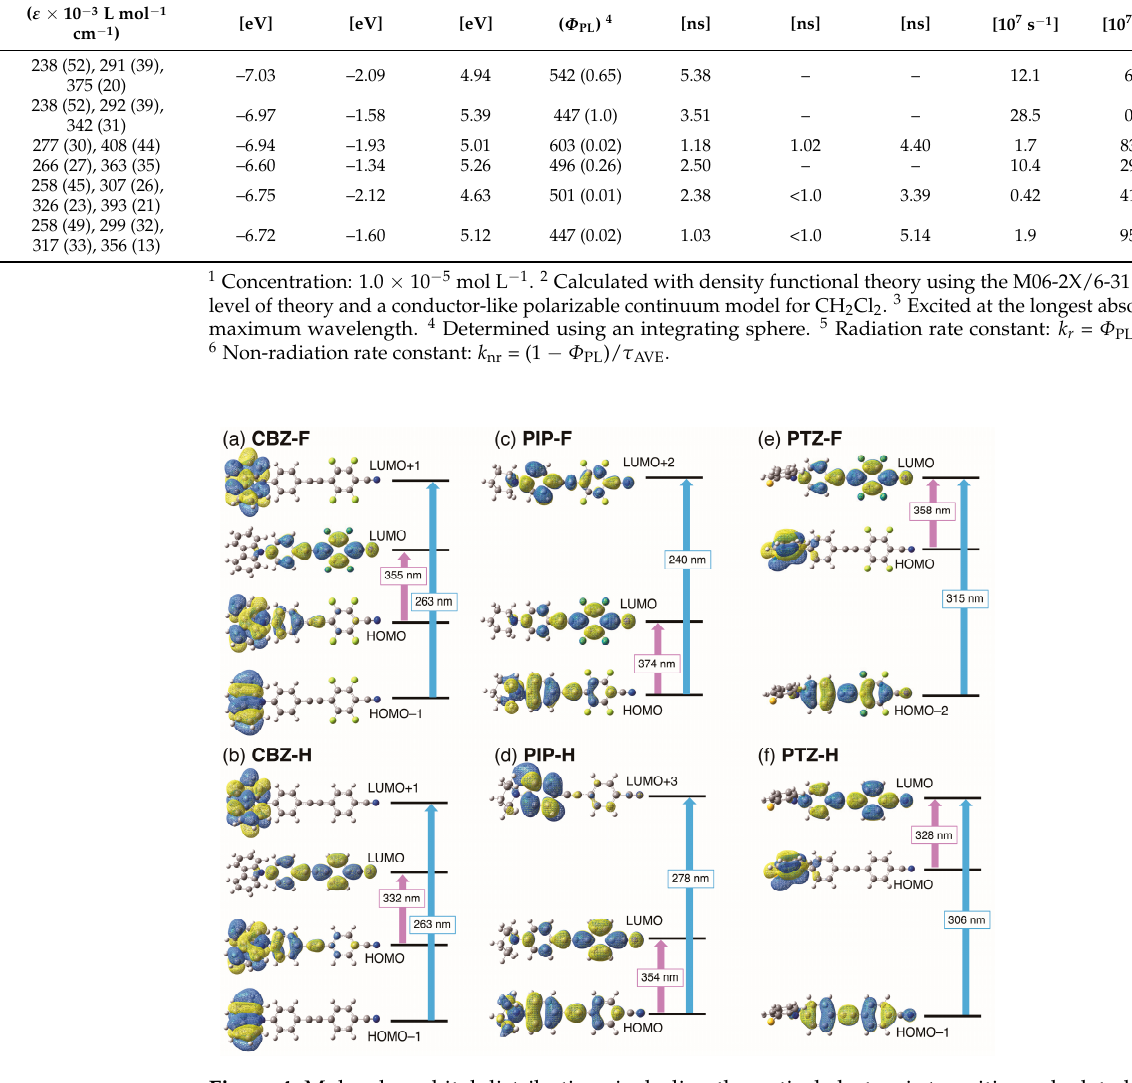
Figure 4 Figure 4. Molecular orbital distributions including theoretical electronic transition calculated using Table 2. Theoretical values of vertical transition behavior calculated using TD-DFT 1